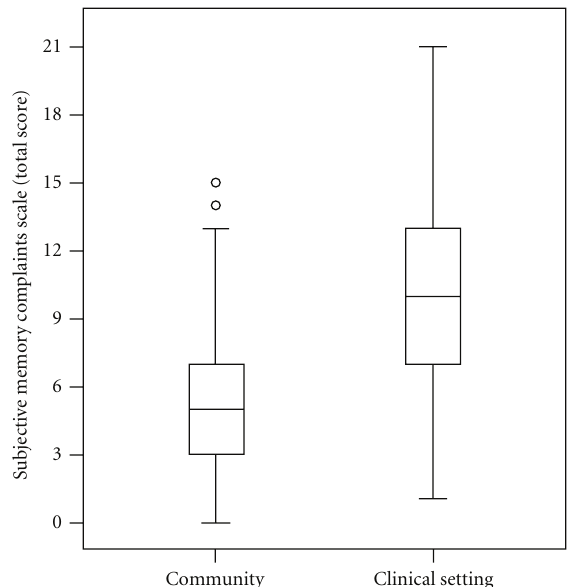
Figure 1: Total SMC scores in the community and in the clinical setting.